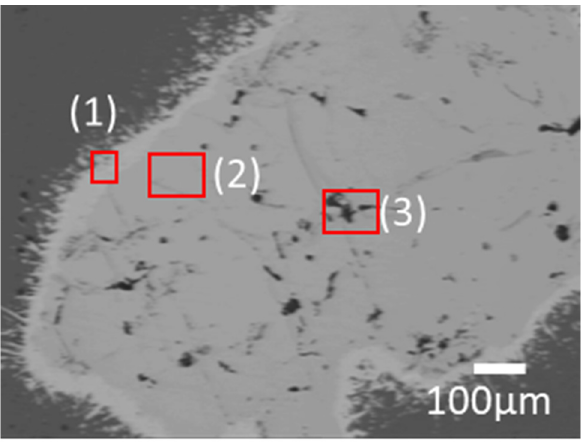
Figure 3. Microstructure of FeB after the reaction experiment between Mg and FeB ( × 50 magnification). Table 1. EDS results for observing the composition of phases in (1), (2), and (3) of Figure 3. Composition (wt.%)